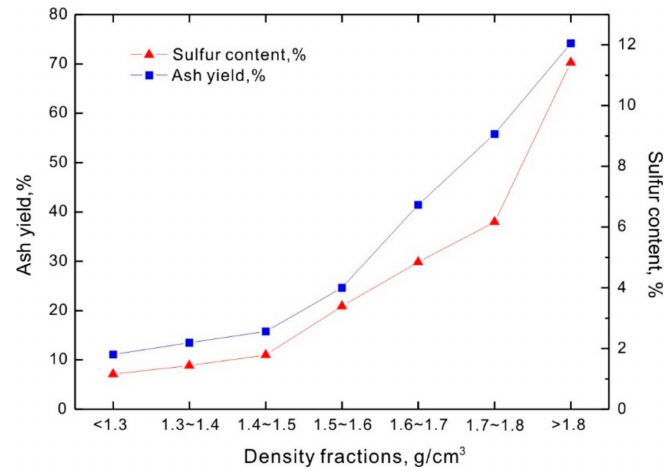
Figure 3. Ash yield and sulfur content in different density